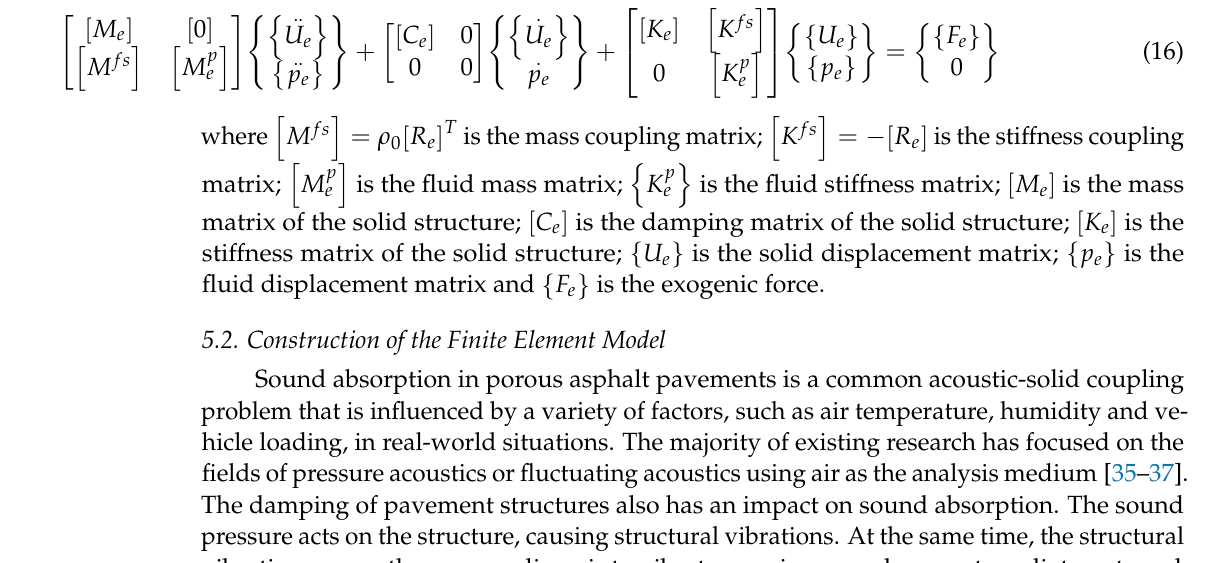
Table 7. Material parameters involved in the simulation.